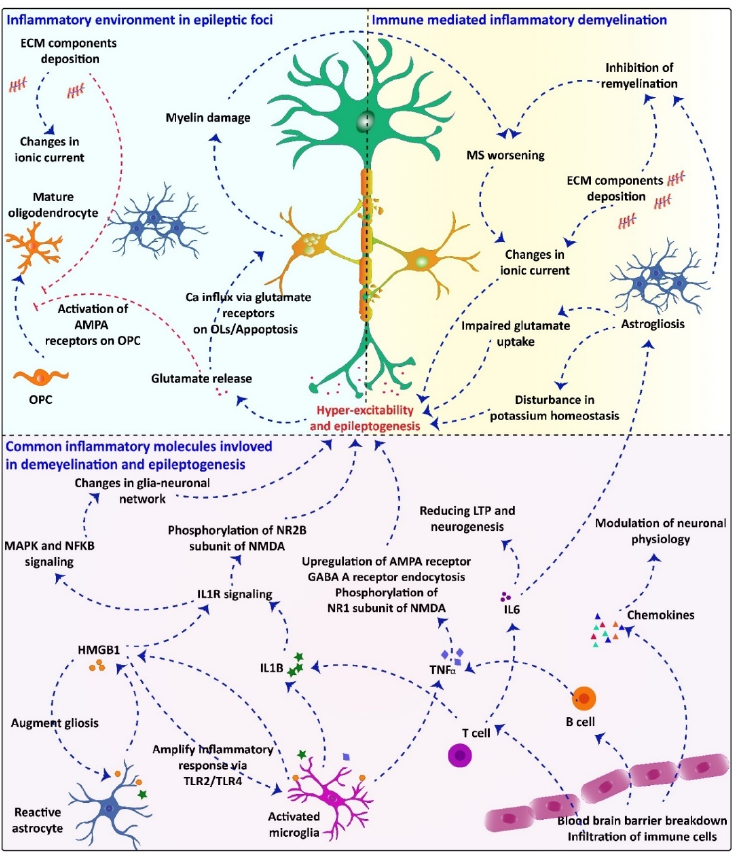
Figure 1. The common inflammatory mechanism underlying demyelination and epilepsy and how one can pathology accelerate the other is proposed: Inflammatory processes in MS pathology are also involved in the etiology of seizures and trigger hyper-excitability. In turn, inflammation, gliosis, ECM component deposition, blood–brain barrier breakdown, immune cells infiltration, and production of inflammatory mediators such as IL-1B, IL-6, HMGB1, TNF- α , and chemokines might stabilize a common mechanism in the pathophysiology of seizures and epilepsy in MS. Phosphorylation of NR2 subunit of NMDA receptor by IL-1B and HMGB1 may lead to an enhanced NMDA activity and Ca 2+ influx into neurons. Different types of cytokines are released by infiltrated or resident immune cells within the demyelinated lesions. These cytokines can modulate neuronal physiology by changing voltage-gated channels and enhancing discharge of some neurotransmitters. Furthermore, pro- inflammatory cytokines and IL-1B inhibit astrocytic glutamate uptake, leading to hyper-excitability and, subsequently, seizures in the context of MS. Releasing high amount of glutamate and impaired glutamate uptake can induce apoptosis in oligodendrocytes via influx of large amount of Ca 2+ through glutamate receptors. This process exacerbates myelin damage and worsens MS. Collectively, the overall pathology of MS and epilepsy seems different, but some shared mechanisms are undoubtedly present. Each of these two diseases may lead to the occurrence of underlying mechanisms of the other. Therefore, a positive feedback could exist, contributing to the worsening of these conditions. The inflammatory environment of MS lesions modulates neuronal physiology and increases the neuronal excitability, which, in turn, may lead to the development of epileptic seizures. Glutamate released during discharges has several effects on oligodendrocyte lineage cells. This process finally leads to myelin damage that exacerbates MS. The common pathways underlying the pathology of both diseases, how MS pathology can trigger epileptic seizures, and how epilepsy leads to myelin damage and subsequently worsens MS, are proposed in Figure 1. Notwithstanding, further preclinical and clinical studies are required to reveal the precise molecular mechanisms